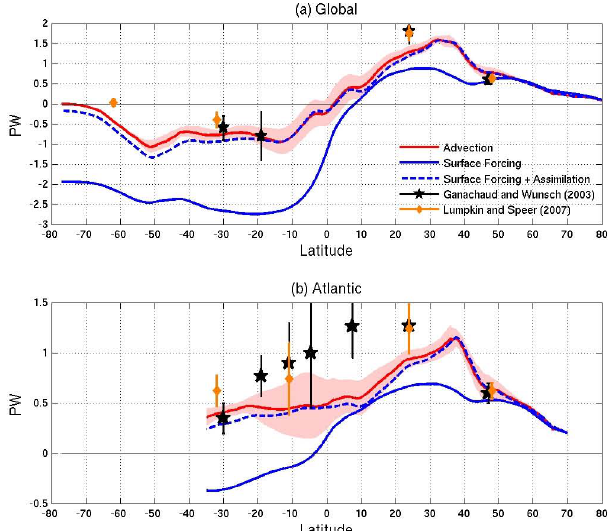
Fig. 4. Meridional heat transports from UR025.3 over 1993–2009 for (a) the global ocean and (b) the Atlantic Basin. The Advection (red) is based on the resolved velocity and temperatures fields, in- cluding all eddy components down to the 5 day time scale. The shaded area shows the annual standard deviations in advective trans- port. The solid blue line uses surface heat fluxes and a steady state assumption to calculate meridional heat transport, and the dashed blue line uses surface heat fluxes combined with assimilation incre- ments to do the